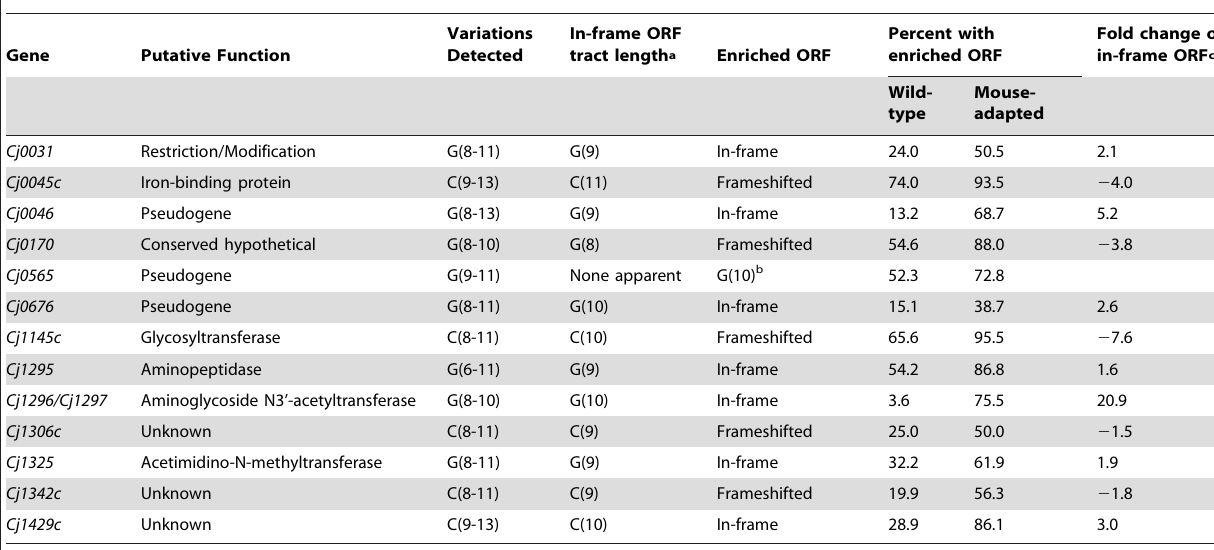
Table 1. Significant open-reading frame changes due to serial passage.